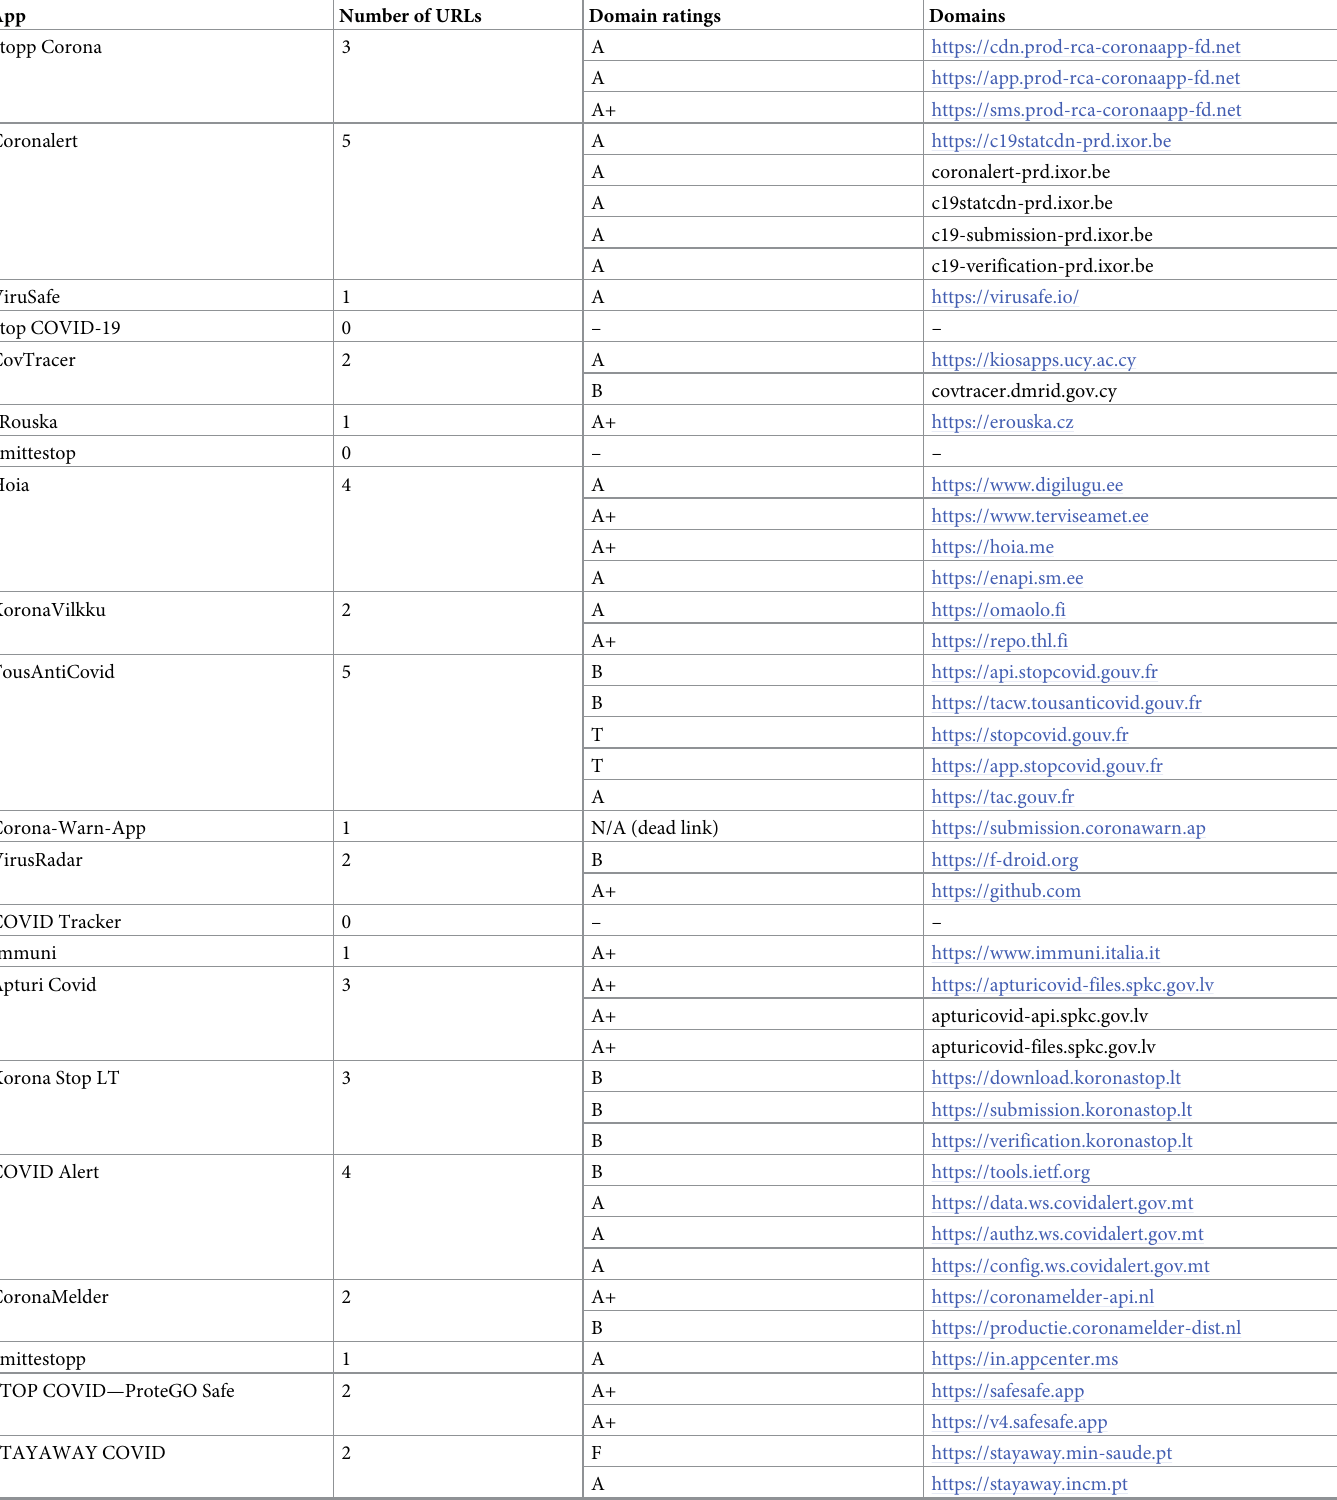
Table 3. TLS server security level rating of external URLs per